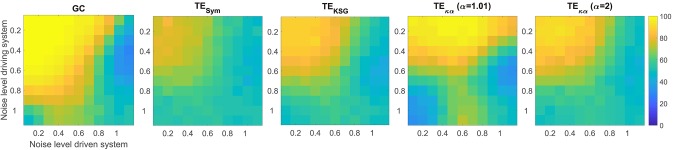
Average accuracies in the detection of the preferred direction of information flow for synthetic data, generated from a unidirectional bivariate autoregressive model of order 3 under asymmetric noise level conditions. The vertical axis displays the noise level for the driving time series, while the horizontal axis does so for the driven time series.